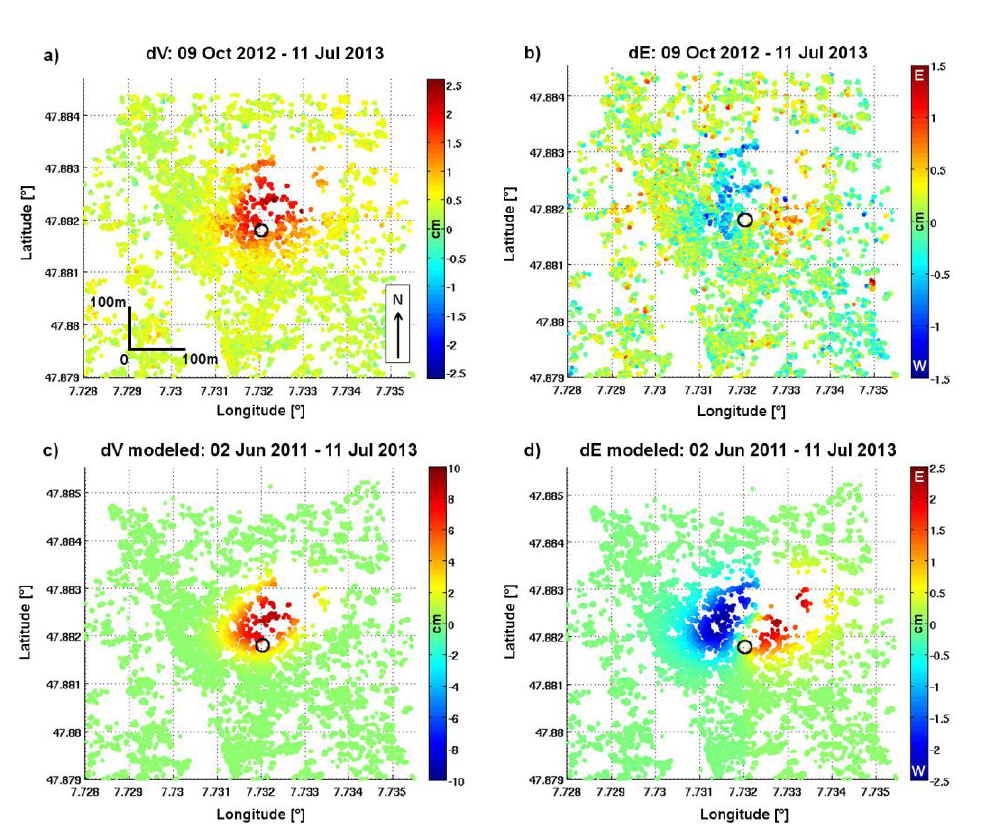
Figure 8. ( a ) Vertical and ( b ) horizontal east-west motion contributions derived from line of sight (LOS) decomposition of ascending and descending SBAS results for the period 9 October 2012 through 11 July 2013. Estimated vertical ( c ) and east-west ( d ) motion from Okada modeling for the period 2 June 2011 through 11 July 2013 for comparison purposes. The black circle indicates the drilling